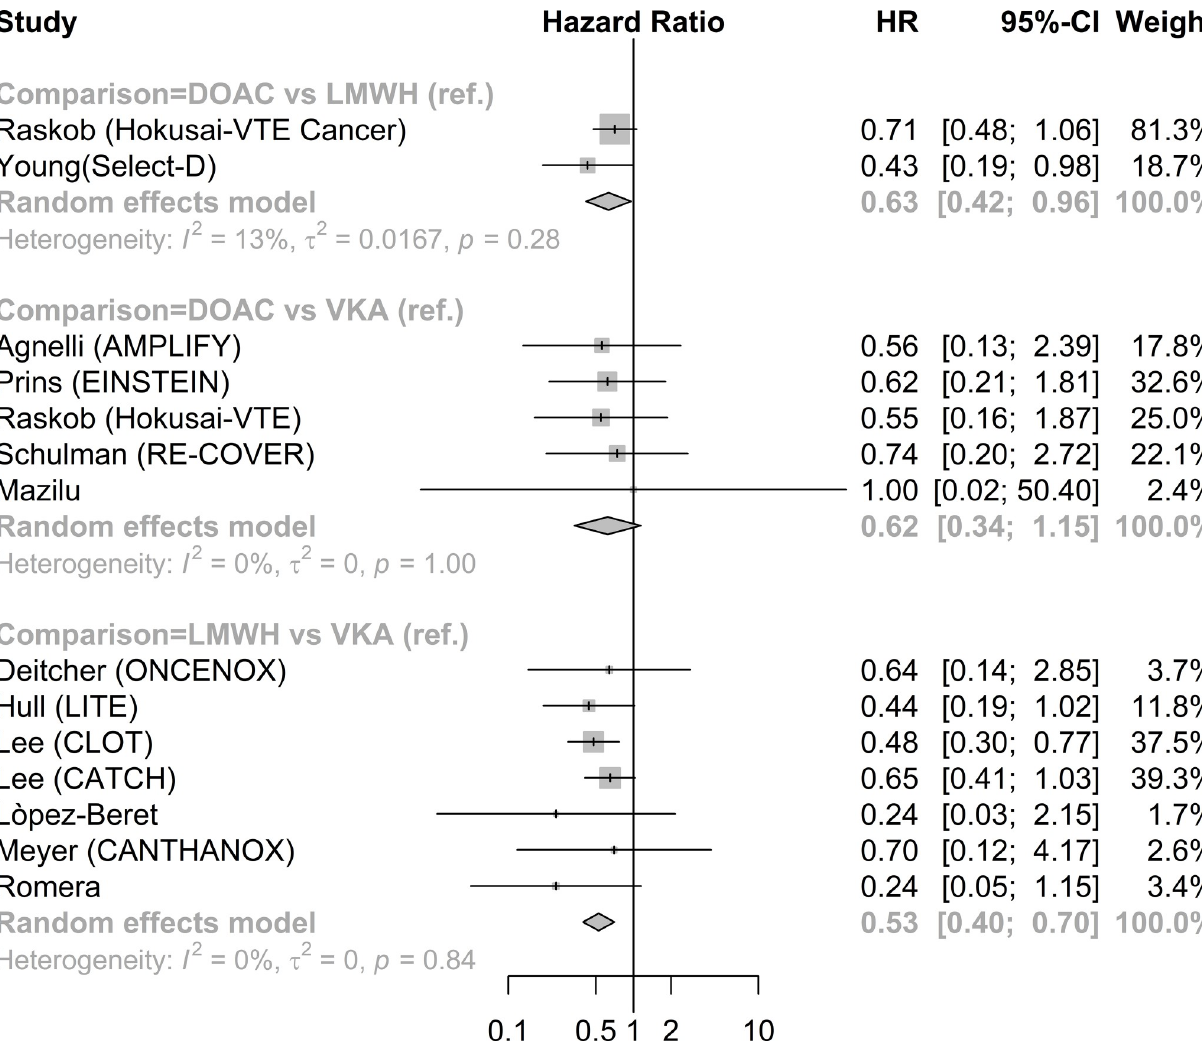
Fig 3. Direct meta-analysis recurrence forest